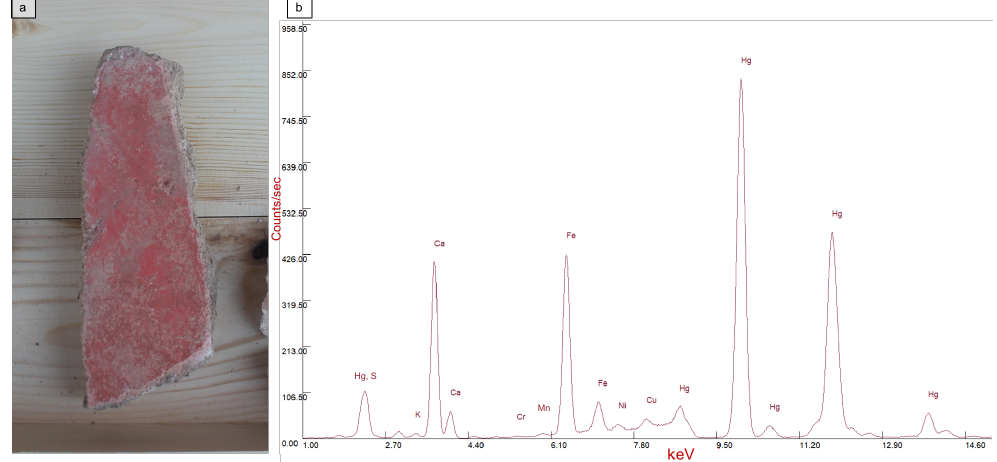
Figure 14. ( a ) A wall painting fragment decorated with cinnabar and red ochre from the House of Orpheus (B2); ( b ) an X-ray fluorescence (XRF) spectrum of the cinnabar-rich paint layer with elemental abundances from the preparation layers. The presence of Cr in the spectrum may be indicative of